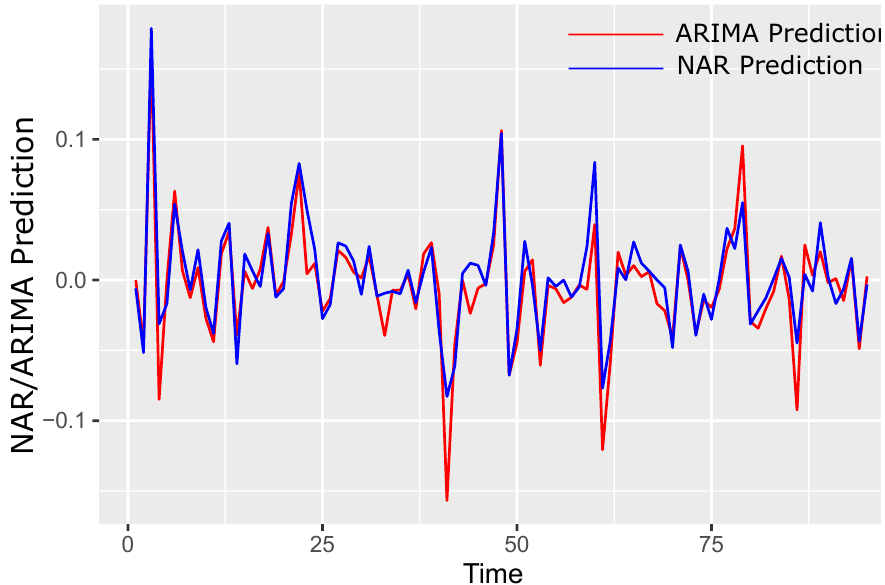
Figure 6. NAR model and ARIMA model for transformed close prices of the Stock 1.